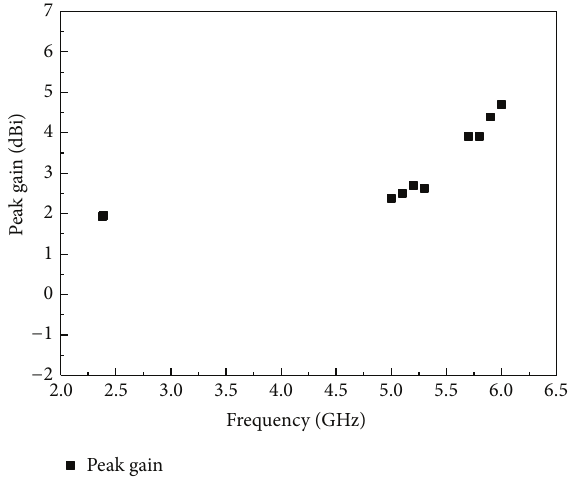
Figure 6: Measured peak gain of the proposed antenna at operational frequency bands.